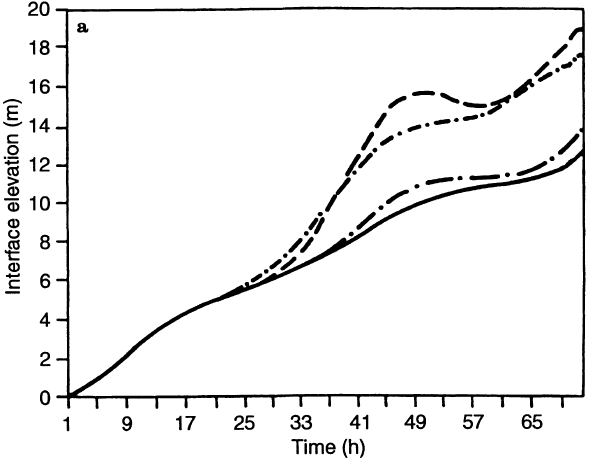
sea-breeze signal after 24 h of integration; short dashed-dot line : sea- breeze signal with NE constant direction after 24 h of integration; long dashed-dot line : sea-breeze signal with constant magnitude after 24 h